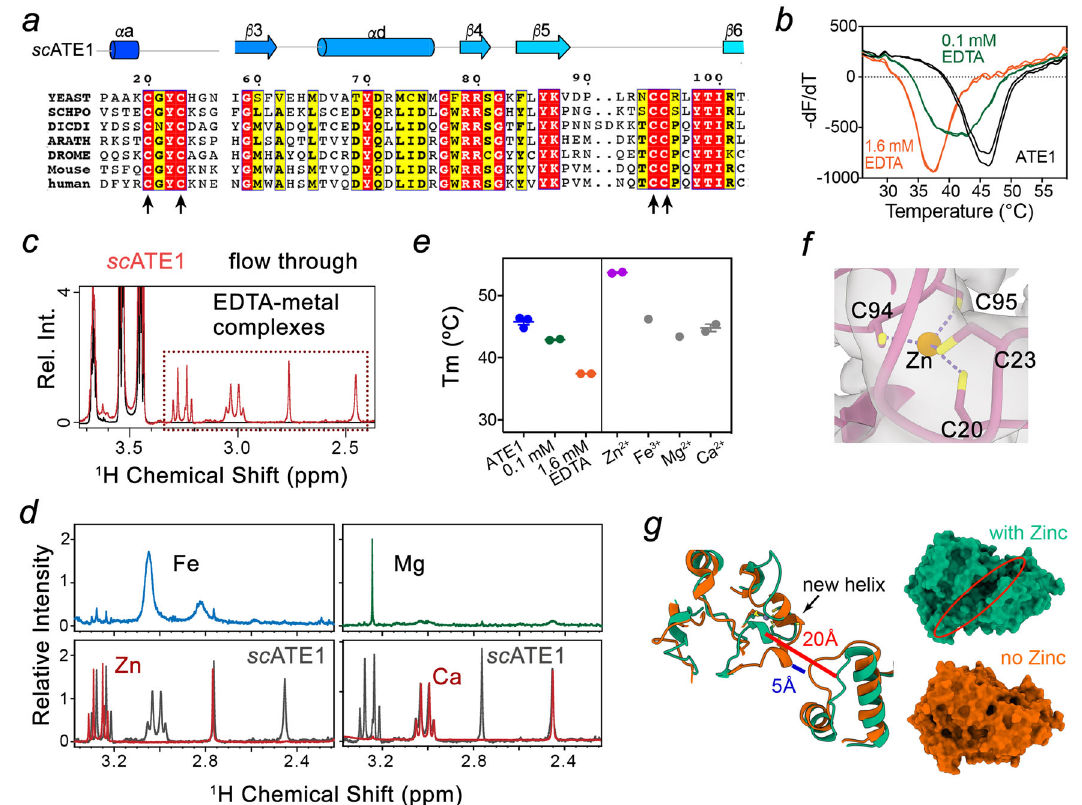
Fig. 2 | Identi fi cation of an atypical zinc- fi nger in sc ATE1. a Multiple sequence alignment for the N-terminal region of curated ATE1 sequences from model organismsusingClustalOmegaanddisplayedusingESPript3.Arrowsandcylinders indicate β -strandsand α -helices,respectively.Redandyellowbackgroundsindicate identical and similar residues, respectively. b ATE1 stability upon addition ofEDTA monitored by DSF. The fi rst negative derivative of fl uorescenceintensity isplotted against temperature. The melting temperature ( T m ) is de fi ned as the in fl ection point of the melting curve, corresponding to the peak. c Superimposed 1 H NMR spectraofEDTA-dissolvedpowderpreparedusinglyophilizedATE1proteinsample (red) and fl ow through (black) from the centrifugal fi lter unit. d Superimposed 1 H NMRspectraofEDTA-metalcomplexesfromATE1proteinsampleandEDTA-cation